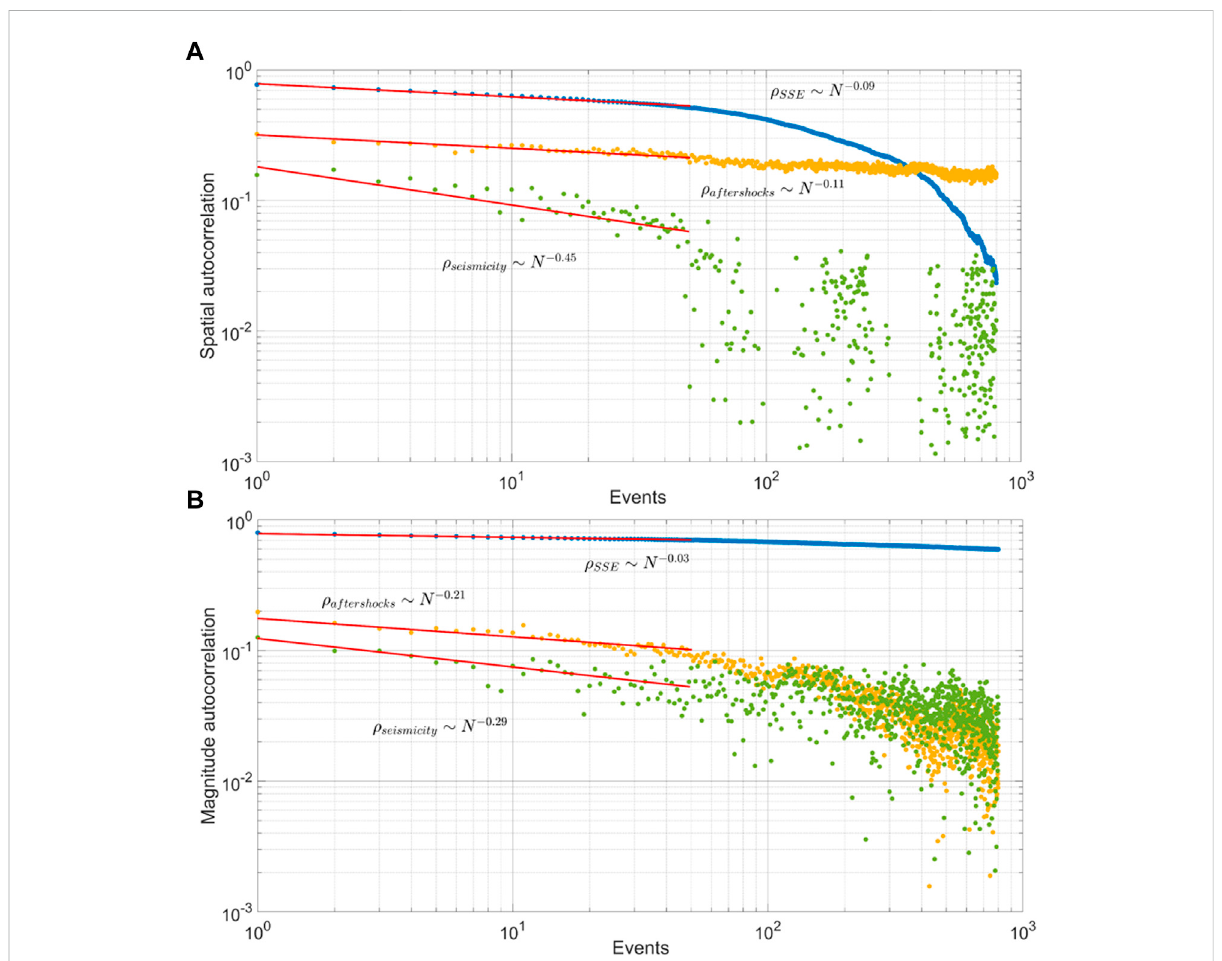
FIGURE 12 Power law memory loss of distance from the fi rst epicenter (A) and magnitude (B) time series is observed after major seismic events, while a faster decrease occurs after moderate magnitude ones. In this fi gure the aftershocks of the Tohoku-Oki megathrust earthquake are considered (orange points) and background seismicity in the Nankai region also (green points). Ultra-slow decay is a peculiar feature of LFEs, which is characterized by strong spatial localization and diffusive behavior along strike (blue points). The spatial autocorrelation for LFEs time series is also featured by a clear violation of the power-law trend as time goes on. This effect depends on the spatial migration of silent